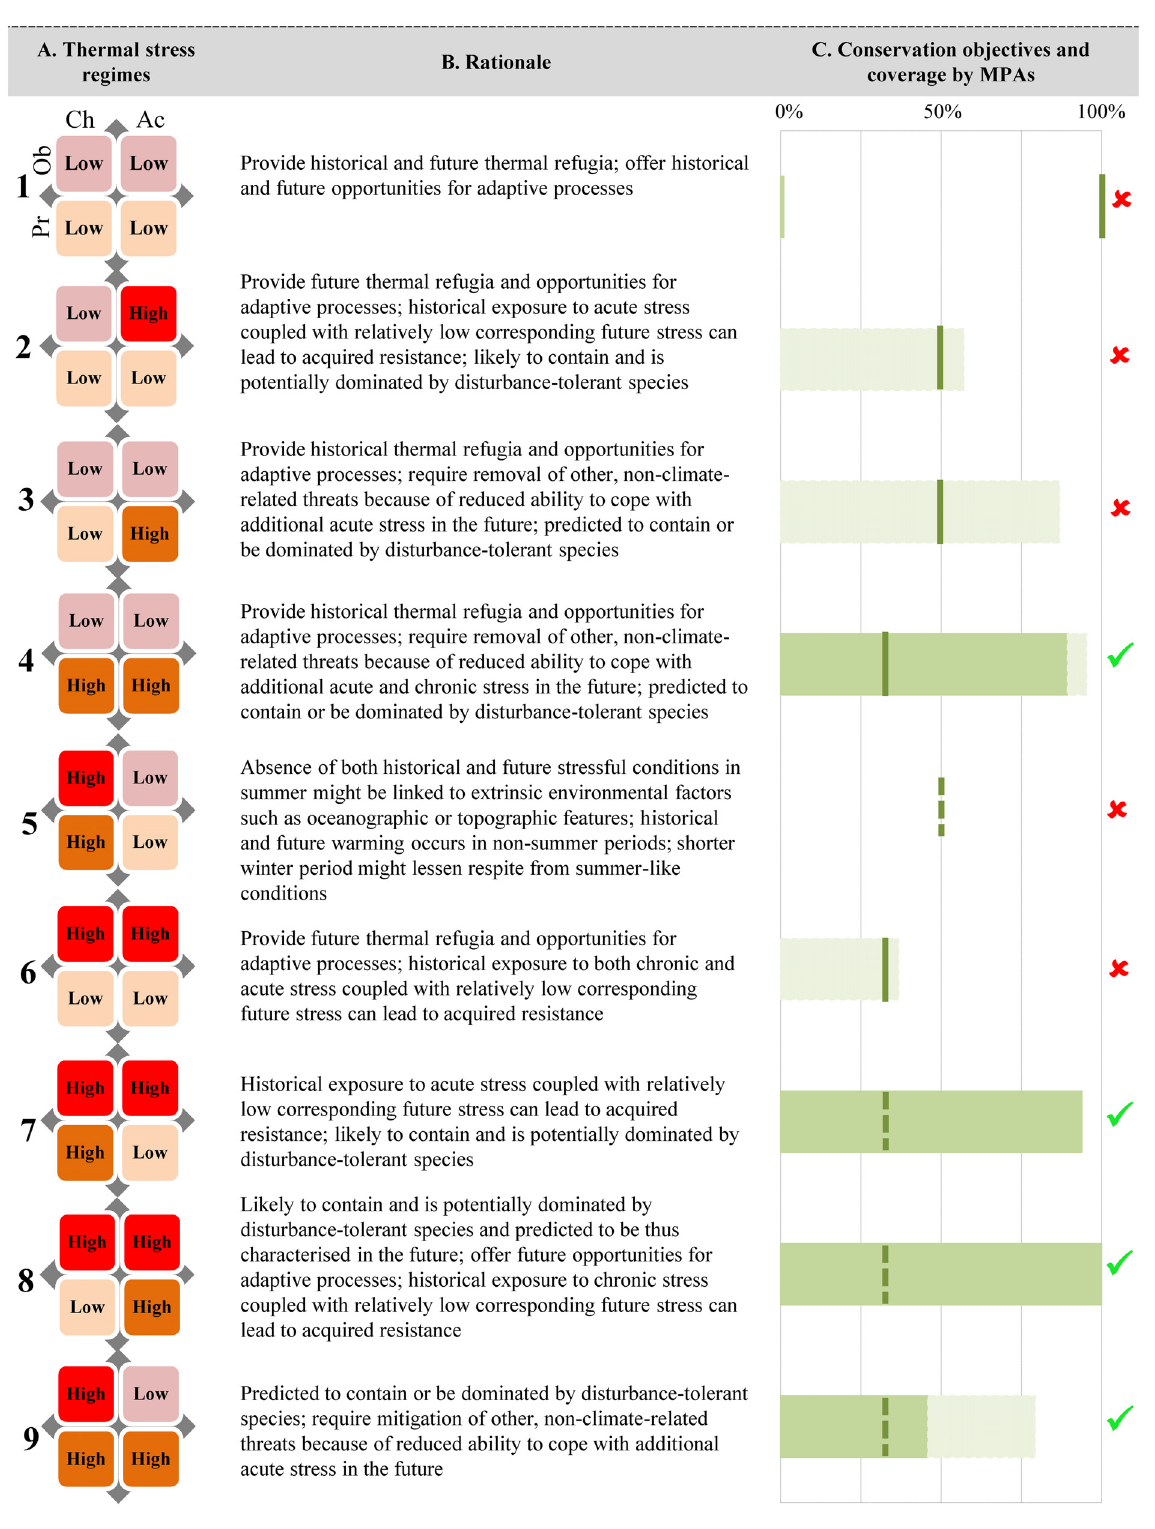
Fig 4. Thermal-stress regimes. The nine thermal-stress regimes defined within our study area (A), defined by combinations of high and low values for observed (Ob) and projected (Pr) chronic (Ch) and acute (Ac) stress. The rationale for management of each regime is summarised in (B). (C) Conservation